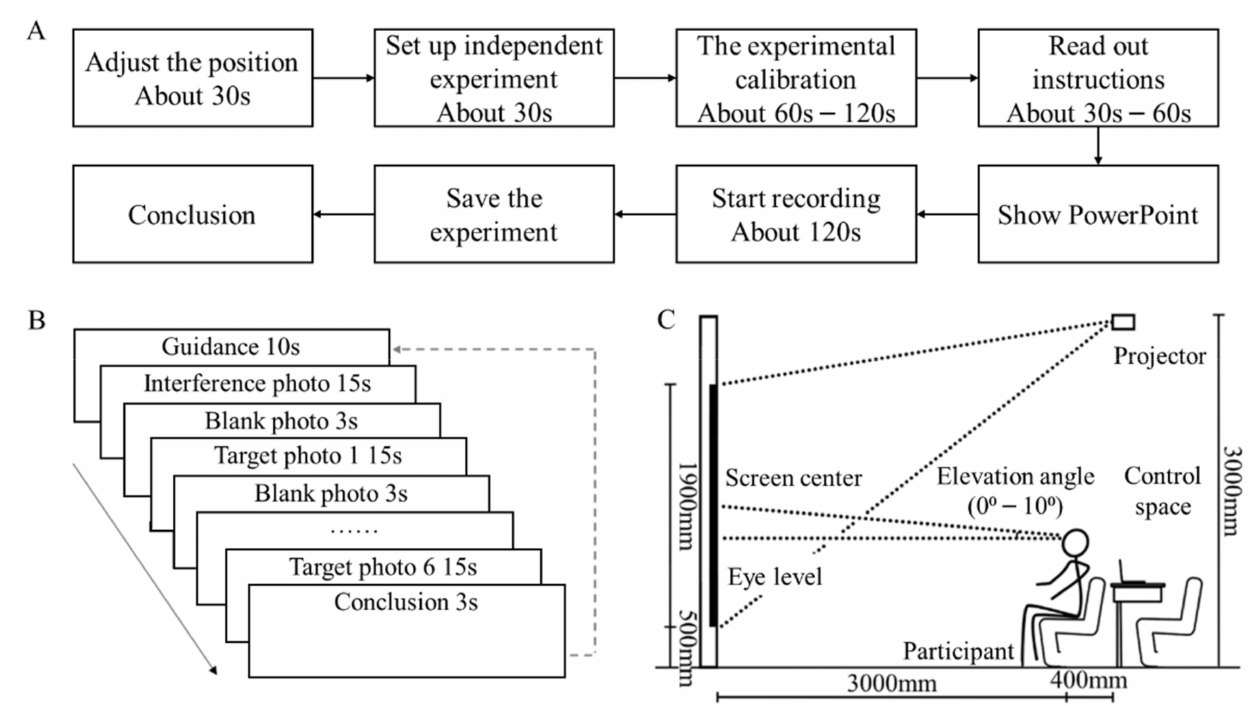
Figure 3. Schematic diagram of the experiment. ( A ): Experimental flow chart in the eye-tracking experiment. ( B ): PowerPoint playback diagram of the eye-tracking experiment. ( C ): Participants’ view schematic of the eye-tracking experiment. This figure was created by Yu Gao (Shenyang Agricultural University).